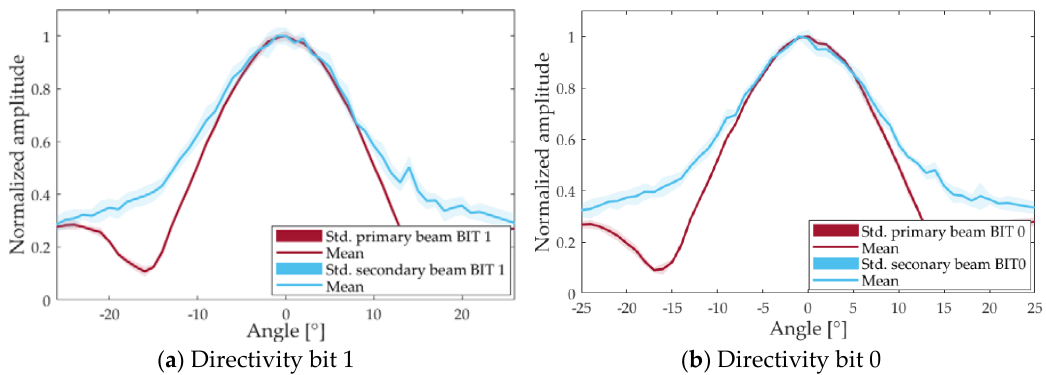
Figure 8. Directivity pattern of the primary and secondary beams.